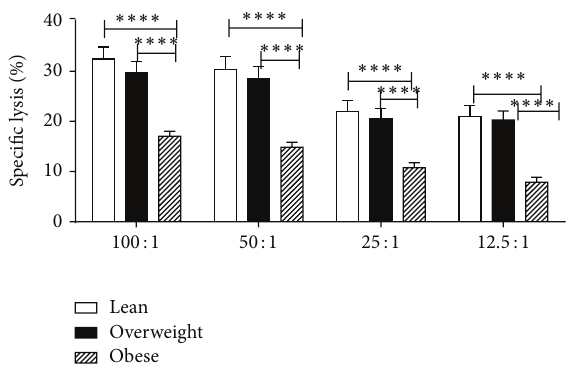
Figure 5: Measurement of natural killer cell activity in lean, overweight,andobesechimpanzees.PBMCsisolatedfromtheblood samples of the chimpanzees were used for determining NK activity in triplicate wells using the standard 51 Cr release assay. Results are expressed as % specific lysis. The values shown were obtained after subtracting the background lysis of control target cells (K652) from that of target cells. The data presented are averages from three different